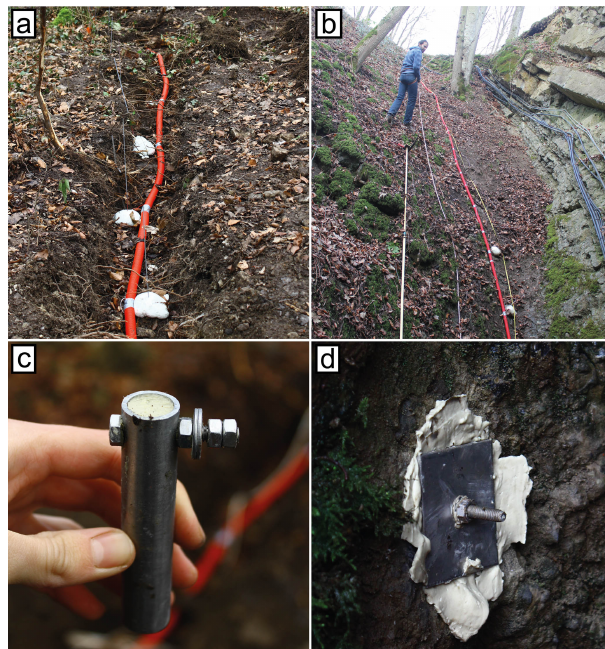
Figure A1. Photos of the ERT profile, with the trench at the top of the plateau (a) ; the situation in the slope of the sinkhole (b) ; the stainless steel hollow tubes used as electrodes in most of the profile (c) ; and the stainless steel plates bolted to the rock at the bottom of the sinkhole (d)